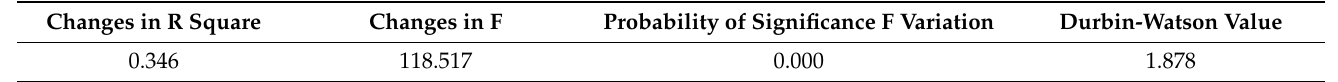
Table 2. Regression Model Summary.